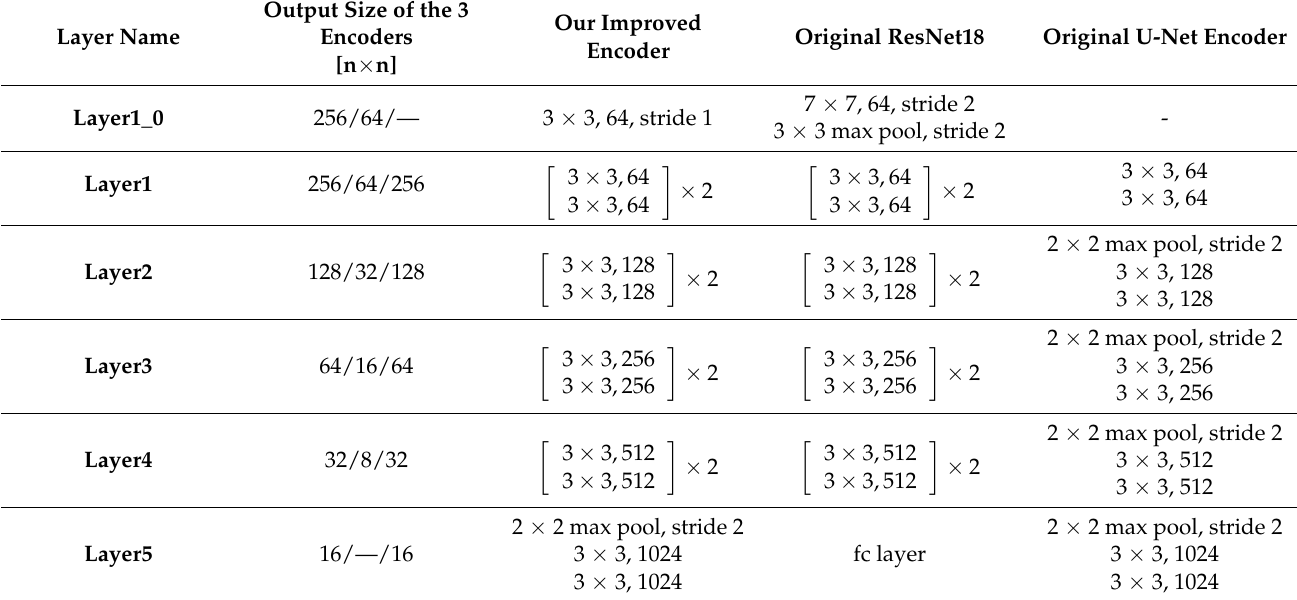
Table 1. Network structure comparison between different